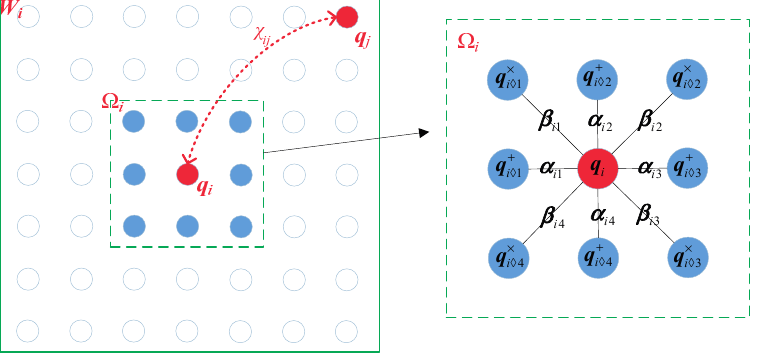
Figure 2. The spatial configuration of the weighted AR